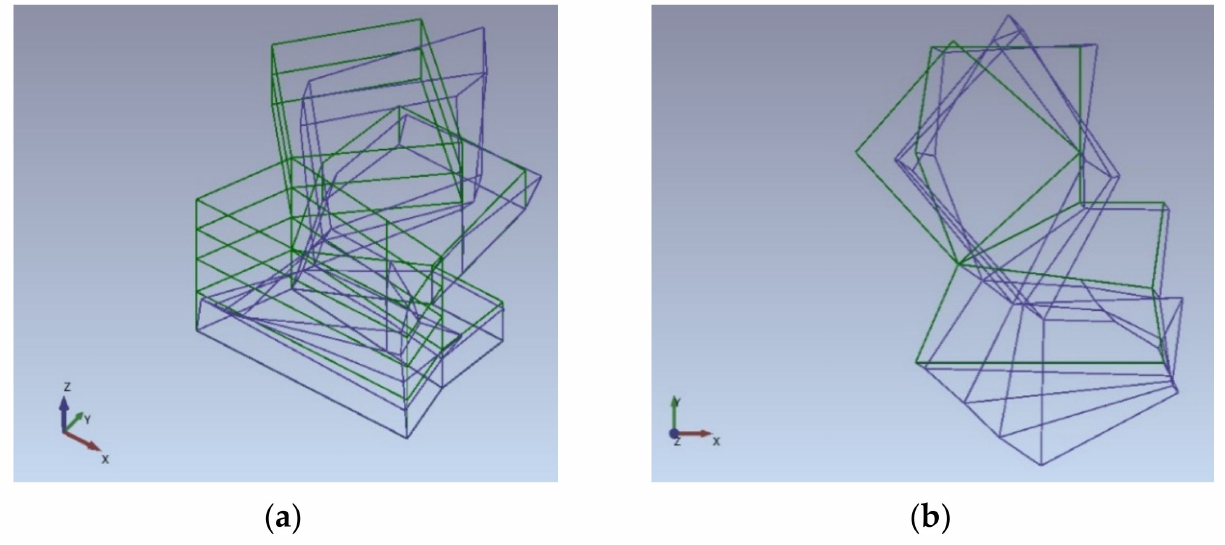
Figure 12. Second experimental mode is a torsional-bending mode along x axis (in green the un- deformed configuration and in blue the mode shape): ( a ) 3D view; ( b ) plan